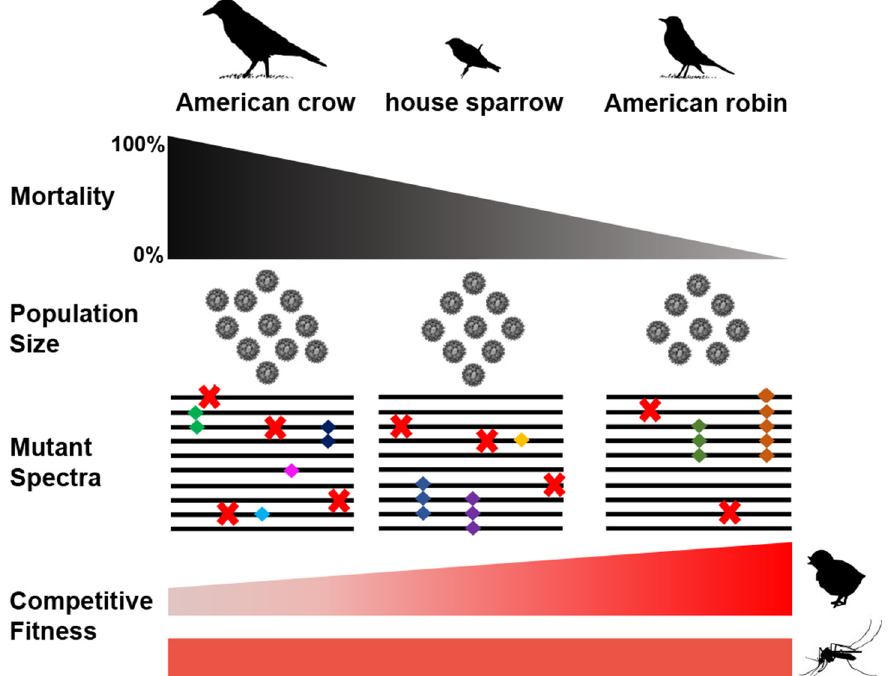
Fig 6. Species-specific composition of WNV populations and competitive fitness. Host mortality and intrahost WNV population sizes are associated with WNV population structure and competitive fitness. The WNV populations from all bird species contain ~1 mutation per genome. However in the crow environment, WNV populations are more tolerant of unique and deleterious mutations (e.g. insertions and deletions), but few mutations rise to high frequency. In the most disease-resistant bird species, robins, the WNV populations are under stronger selection pressures. Robin-associated WNV populations are less tolerant of unique and deleterious mutations, and more mutations reach high frequency. The selective environment of more disease-resistant birds was also positively associated with competitive fitness in young chickens, but not in mosquitoes. Population size: each “ virus ” represents a log 10 of GE/ml. Mutant spectra: “ X ” represents deleterious mutations, “ diamonds ” represent neutral or advantageous mutations, and diamonds of the same color represents the same